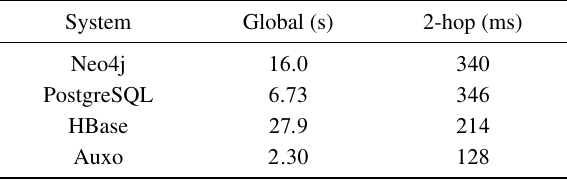
Table 4 Query performance of different